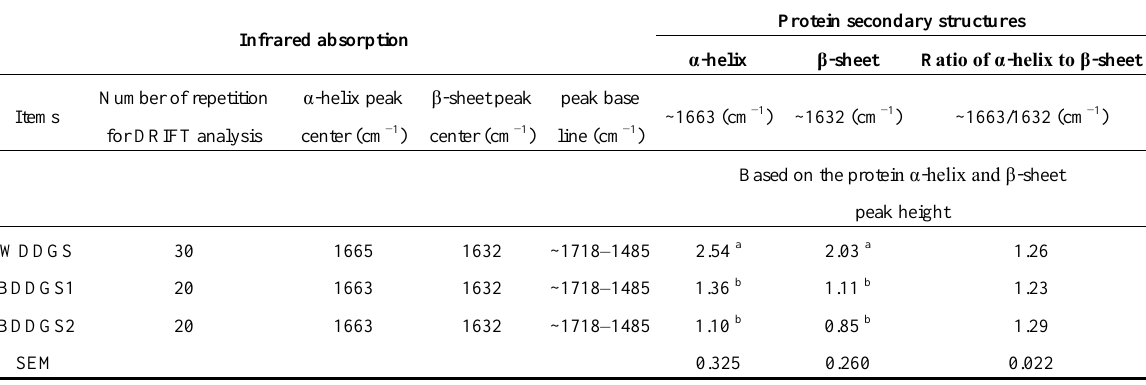
Table 3. Characteristics of protein secondary structures (α-helix, β-sheet, and their ratio): Comparison using DRIFT molecular